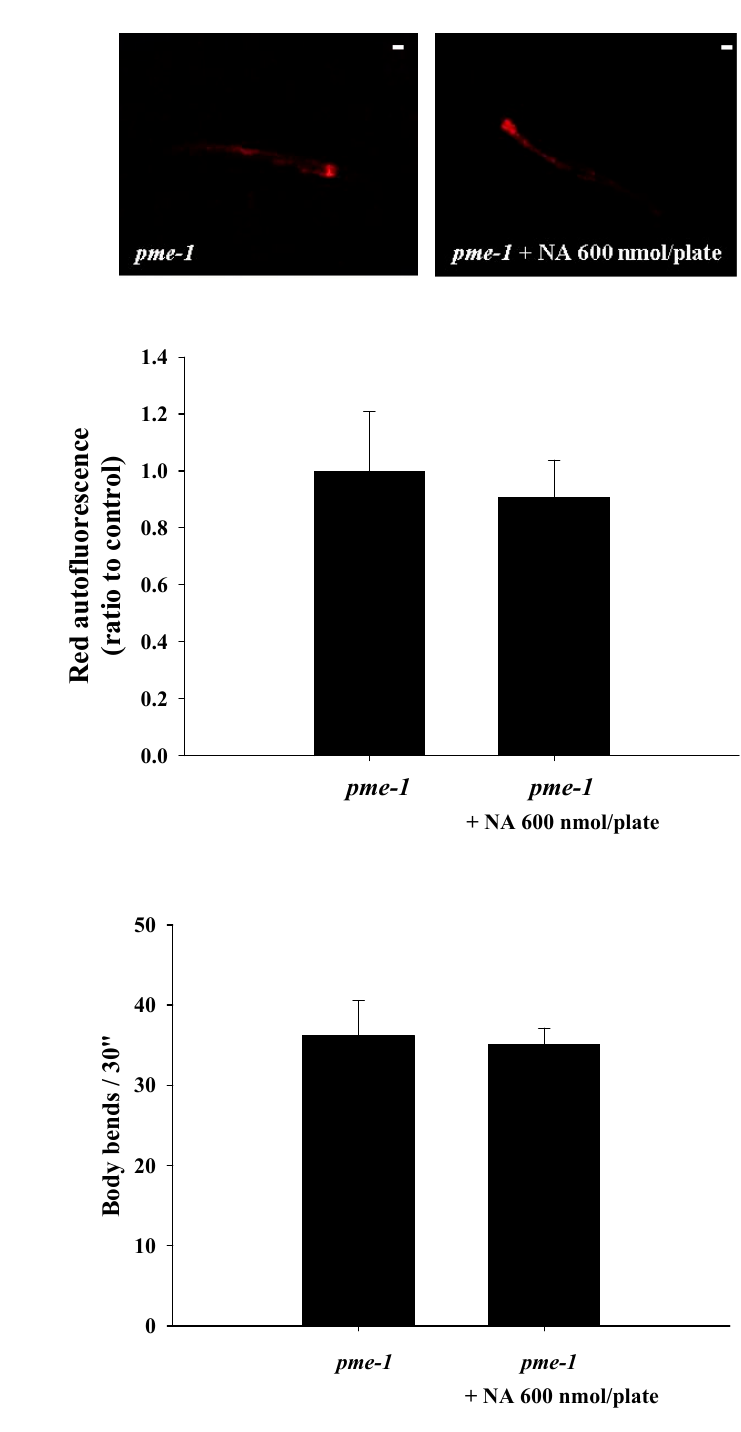
Figure 6. Effects of nicotinic acid (NA) on the level of intracellular NAD + , lifespan, pharyngeal pumping, autofluorescence, and body bends of pme-1 mutants. The mutants were grown on plates with or without 600 nmol NA/plate. ( a ) The intracellular NAD + levels ( n = 3 independent experiments) and ( b ) lifespan ( n = 90 worms). ( c ) On the third, fifth, and seventh days of life, pharyngeal pumping ( n = 10 worms) was performed. ( d ) On the 10th day of life, red autofluorescence ( n = 3 worms) was measured. ( e ) On the 11th day of life, body bend ( n = 10 worms) was determined. Values are expressed as the mean ± SD; asterisks * indicate significant changes ( p < 0.05) compared with the control mutants. Scale bar is 100 μ m.